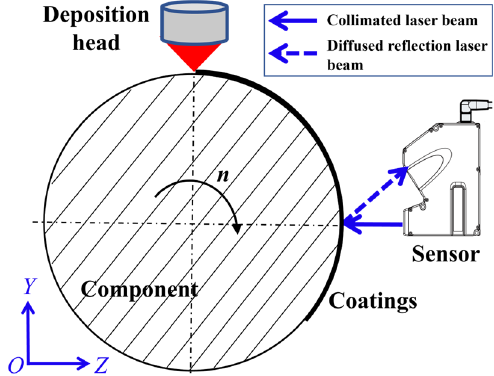
Figure 4. Schematic diagram of the relative positions of the sensor, deposition head, and compo- nent.